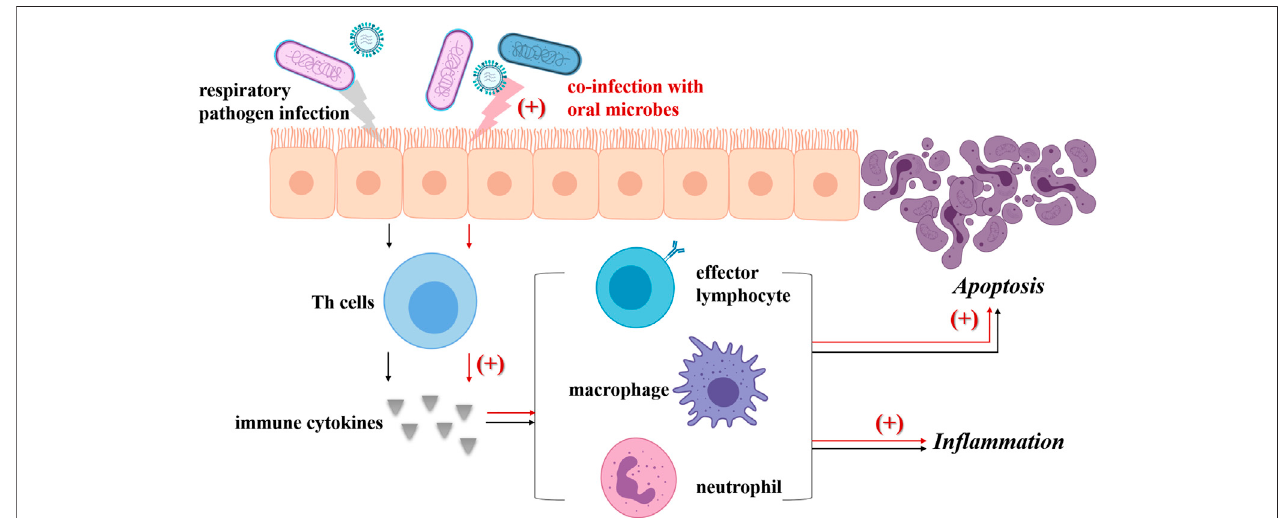
FIGURE2| Co-infectionwithoralmicrobesstrengthsthepathogenicityofrespiratorypathogens.Usually,respiratorypathogeninfection(blackarrow)couldinduce the Th cellstoproduce cytokines, then lead tothedifferentiation, activation and recruitmentofeffector lymphocytes,neutrophils and macrophages. Theseimmunecells not only bring about in fl ammation, but also activate the death receptor apoptotic pathway and fi nally lead to apoptosis. Once oral microbes (including oral streptococci , P. gingivalis , F. nucleatum and A. actinomycetemcomitans , Prevotella intermedia , C. albicans ) inhaled into airways co-infect respiratory epithelium with respiratory pathogens (red arrow), the levels of multiple cytokines are elevated including TNF- α , IL-1ß, IL-6, as well as those signaling pathway related with apoptosis of respiratory epithelial cells. Besides, some oral microbes can promote the virulence of respiratory pathogens, for example, via increasing the virulence factor production or forming pathogenic partnerships. As a result, aggravated in fl ammation and expanded apoptosis is